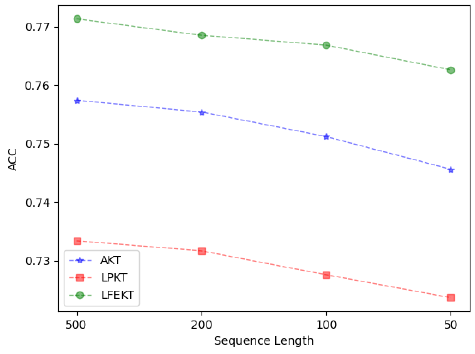
Figure 5. ACC at different sequence lengths.